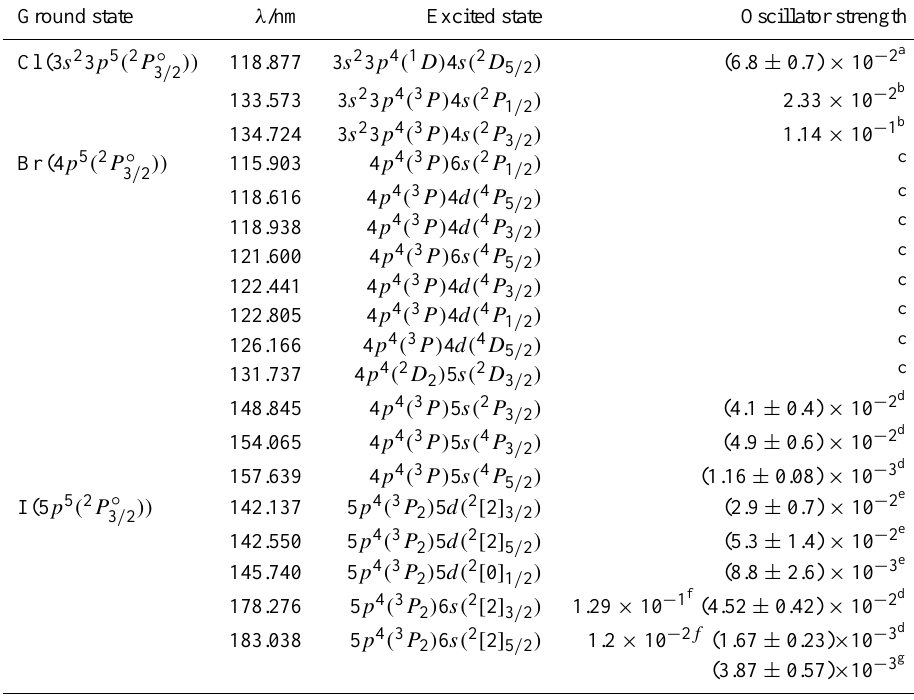
Table 2. Wavelength, excited state and oscillator strength of halogen atom resonance lines used in RF instruments reported in the